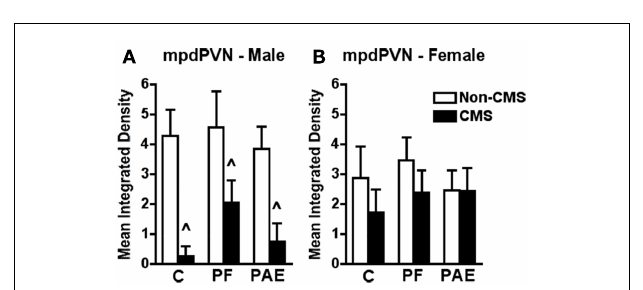
FIGURE 4 | Medial parvocellular dorsal division of the paraventricular nucleus of hypothalamus c-fos mRNA expression in response to the elevated plus maze test in male (A) and female (B) control (C), pair-fed (PF), or prenatal alcohol exposed (PAE) rats, with or without exposure to chronic mild stress (CMS) in adulthood . Bars represent the integrated density (mean ± SEM) of c-fos mRNA expression in the mpdPVN. ∧ Indicates a significant main effect of CMS exposure ( n = 4–5 for all